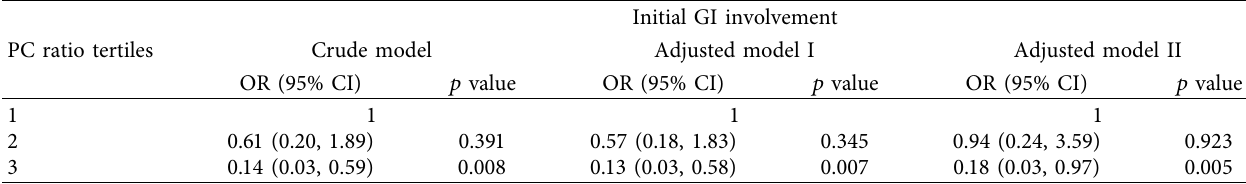
Table 3: Relationship between PC ratio and initial GI involvement.